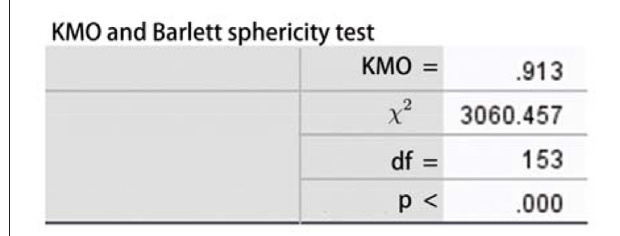
FIGURE 5 | Kaiser–Meyer–Olin (KMO) and Bartlett’s test.